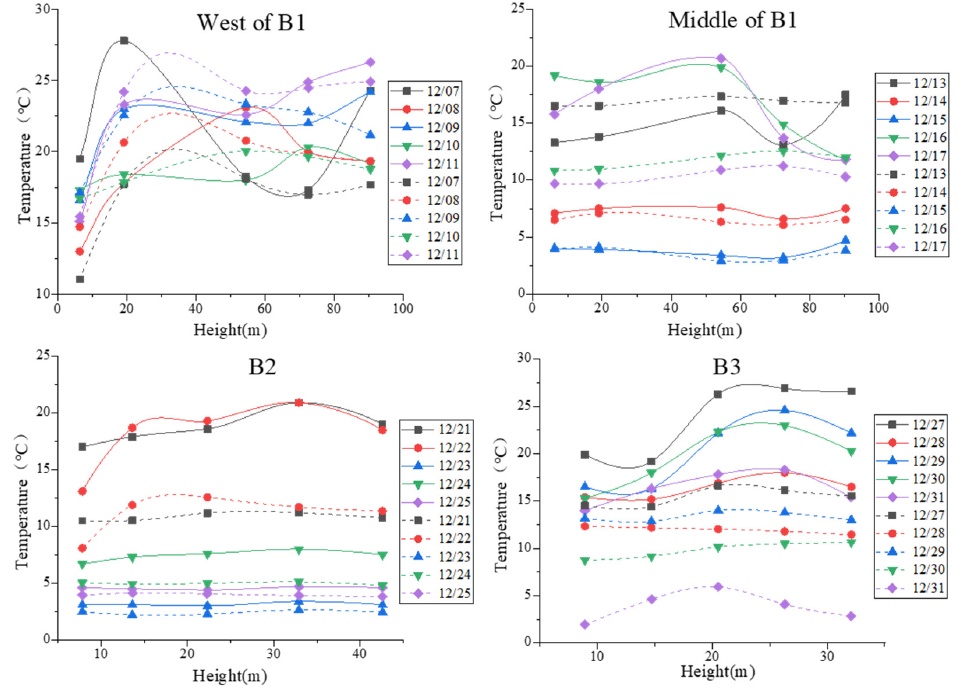
Figure 8. The variation trend of near-wall temperature with height in winter.